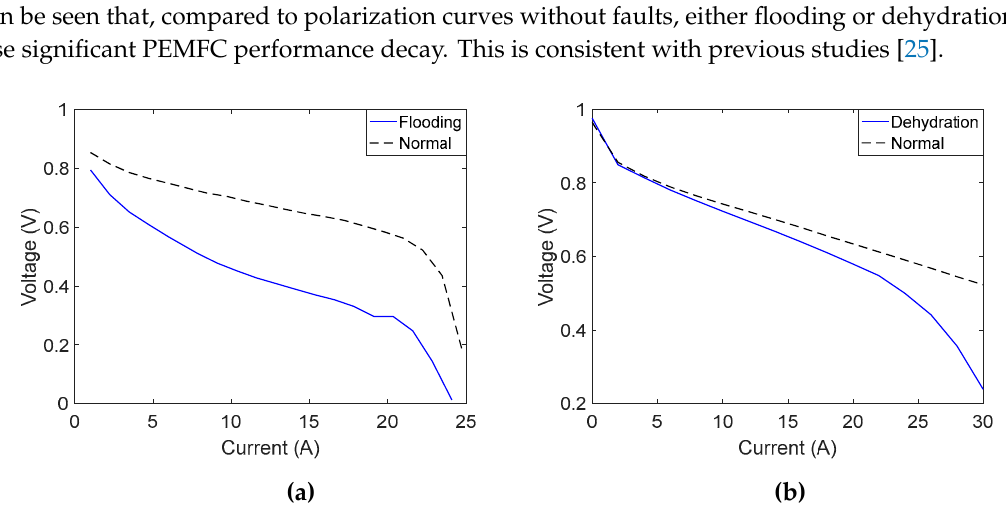
Figure 7. Collected V-I curves before and after the PEMFC faults occur. ( a ) Flooding; ( b ) Dehydration.